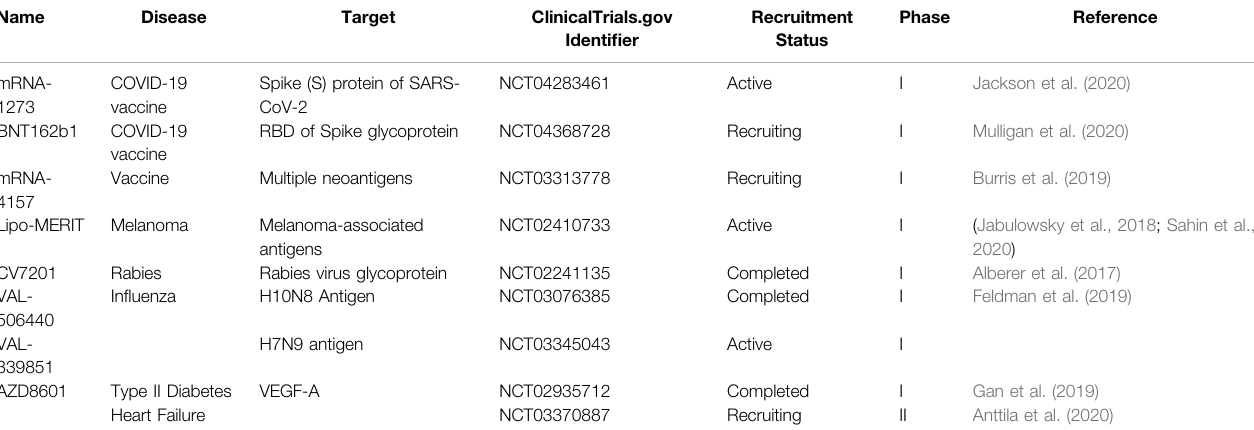
TABLE 3 | mRNA in clinical